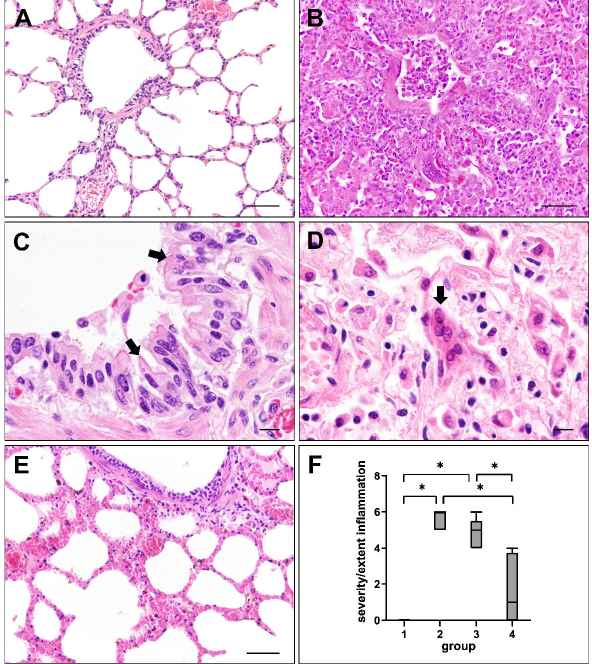
Figure 1. Lung lesions in canine distemper virus (CDV) ‐ infected dogs. ( A ) Non ‐ infected control lung. ( B ) Interstitial pneumonia of a CDV ‐ infected dog (group 2). ( C ) Cytoplasmic viral inclusion bodies in airway epithelial cells (arrows) of a CDV ‐ infected dog (group 3). ( D ) Syncytia formation (arrow) in a CDV ‐ infected lung (group 2). ( E ) Mild pulmonary changes during subacute ‐ chronic infection (group 4). ( F ) Intensity of inflammatory responses at different phases of CDV infection. Groups: 1 = non-infected controls; 2 = acute CDV infection; 3 = subacute CDV infection; 4 = subacute-chronic CDV infection; box and whisker plots display median and quartiles with maximum and minimum values. Significant differences ( p ≤ 0.05, Kruskal–Wallis H test) are labelled by asterisks. Scale bars: ( A , B,E ): 50 µ m; ( C , D ): 10 µ